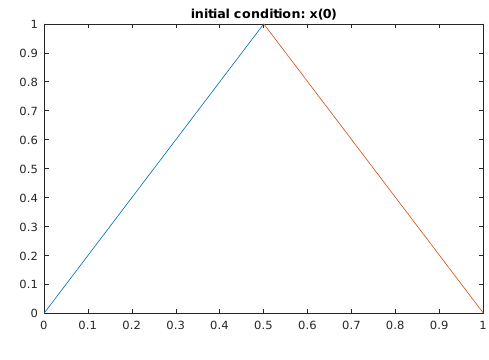
Figure 1. Initial condition.